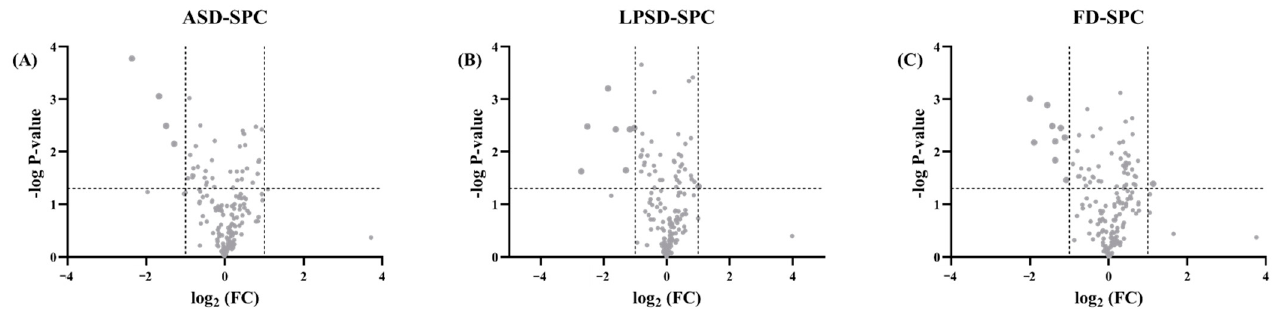
Figure 6. Volcano plots of serum proteins after different drying methods compared with SPC. ( A ) Represents the significantly changed proteins in ASD powder compared with SPC. ( B ) Represents the significantly changed proteins in LPSD powder compared with SPC. ( C ) Represents the significantly changed proteins in FD compared with SPC.